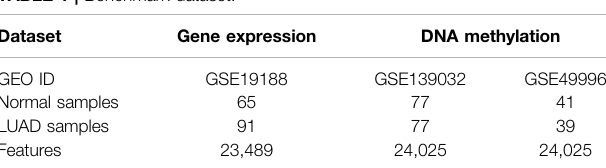
TABLE 1 | Benchmark